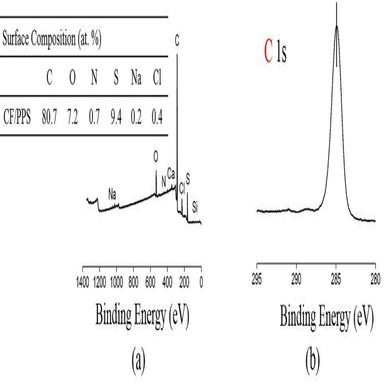
XPS Spectra CF-PPS Composite; (a) Overall spectra, and (b) C1 s.